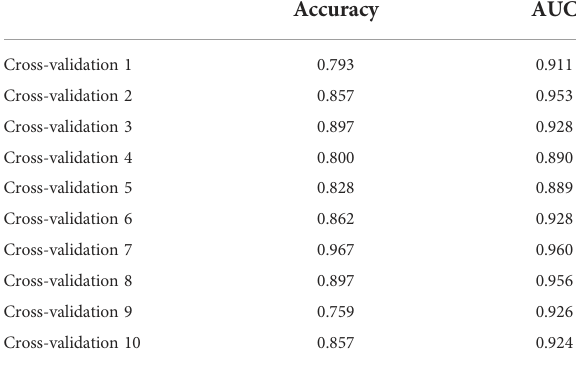
TABLE 3 The 10-fold cross-validation